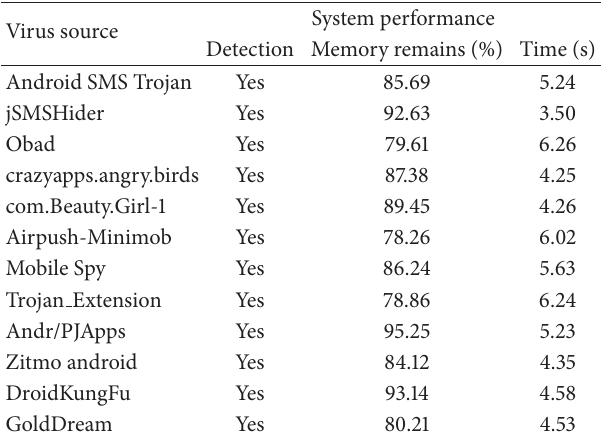
Table 6: System performance